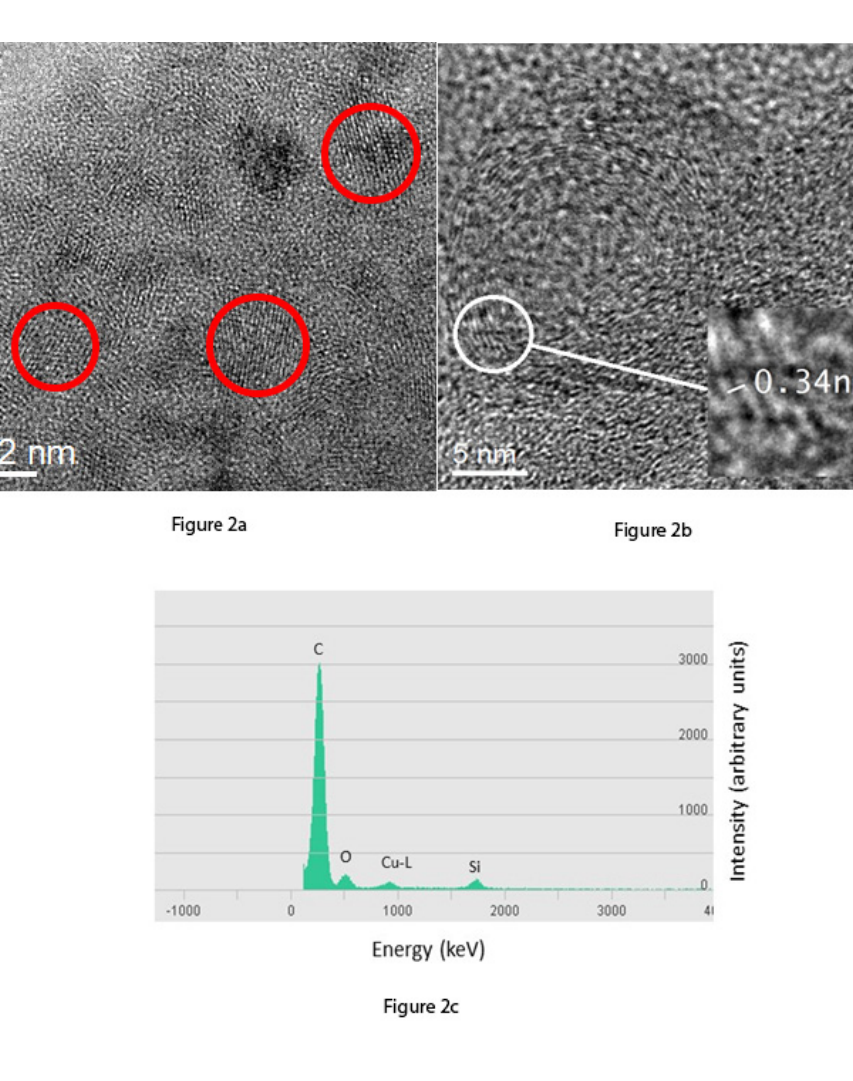
Fig. 2 – (a) HRTEM image of the sample treated in high vacuum showing crystalline structures related to cobalt randomly distributed; (b) HRTEM image of another region of the sample, where there is the presence of “Onion-Like-Carbon” structures; (c) EDS spectrum of the structures shown in Figure 2b .